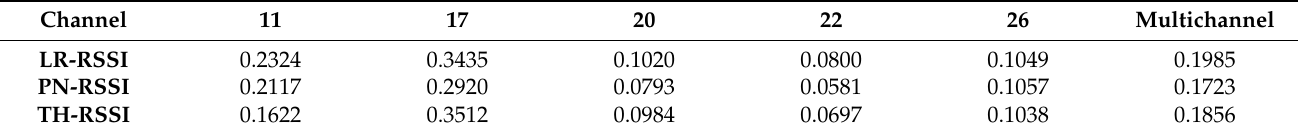
Table 3. RMSEs of the models of RSSI and PRR under the single channel and multichannel